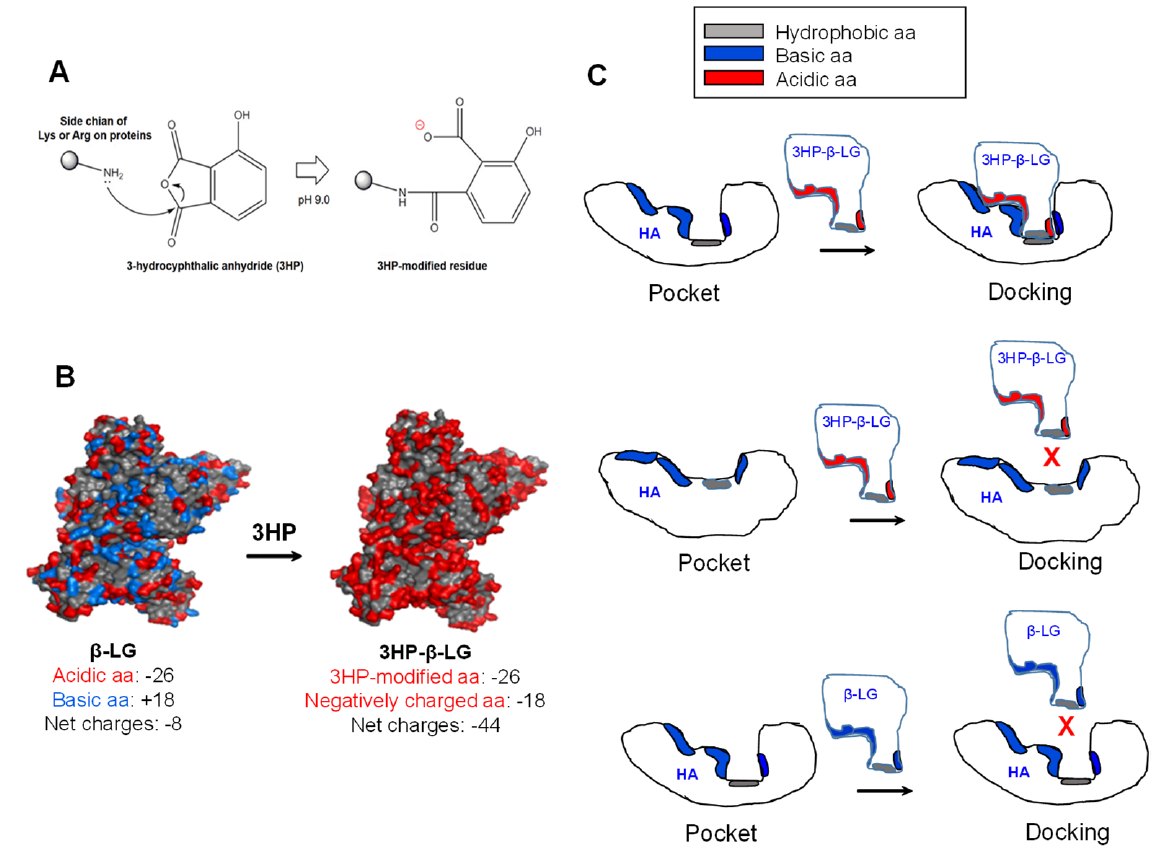
Figure 7. Modification of β -LG with 3HP and the binding model of 3HP- β -LG to the pocket region in viral HA. ( A ) Modification of a positively charged basic amino acid with 3HP results in generation of a negatively charged amino acid. ( B ) Modification of the positively charged basic amino acids in β -LG results in generation of 3HP- β -LG with much increased negatively charged amino acids. ( C ) 3HP- β -LG with enriched negatively charged residues can bind to the pocket in HA with matched conformation (upper panel), but cannot bind to the pocket in HA with non-matched conformation (middle panel). β -LG with enriched positively charged residues can bind to the pocket in HA with matched conformation (lower